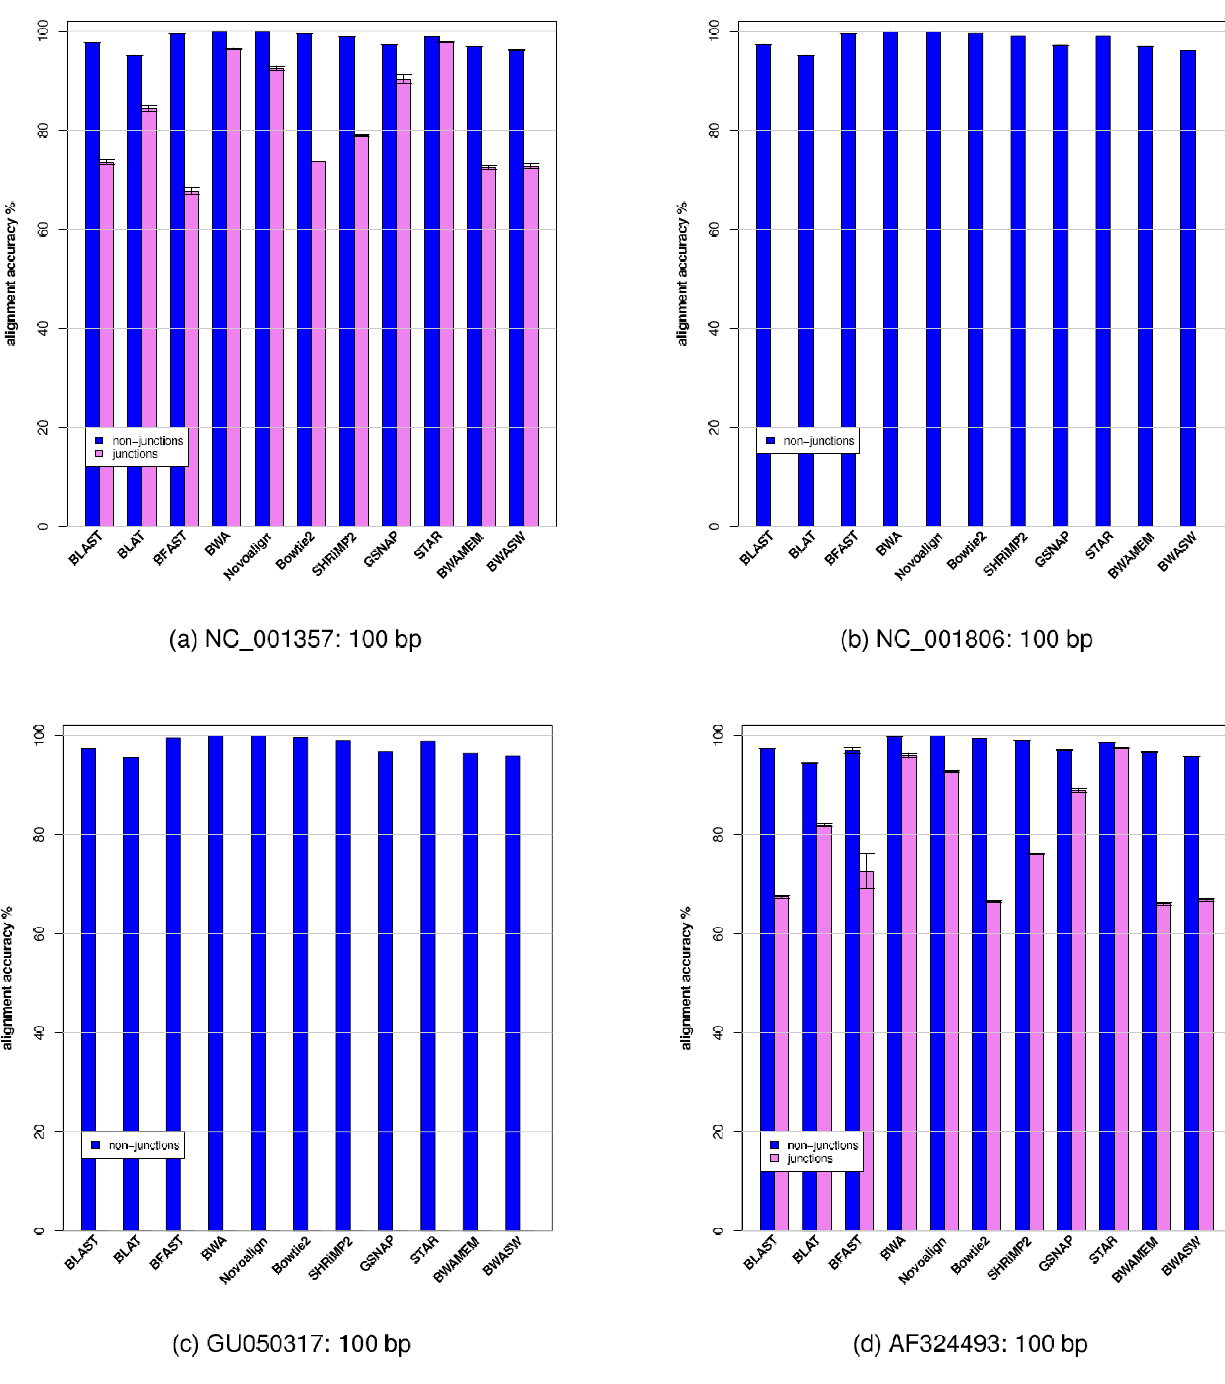
Figure 2. Histogram plot of the average alignment accuracy (averaged over 10 runs) for each viral genome. Histogram plot of the average alignment accuracy averaged over 10 runs for each viral genome shown in Table 1 and each aligner. Reads crossing splice junction regions are shown in pink, reads not crossing splice junction regions are shown in blue). doi:10.1371/journal.pone.0076935.g002 for a single viral sequence or a population of viral sequences by geometric mean between the F ( b ~ 1) score and the weighted sum taking the arithmetic mean of their individual k values. of the S1 and S2 scores. The k parameter in eq.(1) insures that the proportionate weight is given to the S1 and S2 scores based on the Table 4 shows the values for FS ( b ~ 1, k ~ 0 : 13) for each aligner estimated amount of splicing. Thus for viruses that exhibit limited as a function of the viral mutation rate. The value of the k or no splicing the S1 score dominates over that of S2, and parameter for the data in Table 4 was estimated from the data proportionally more weight is given to the S2 score as the amount presented in Table 2 using viruses that exhibit RNA splicing and of splicing increases. The k parameter in eq.(1) can be estimated by taking the arithmetic mean of their individual k values.